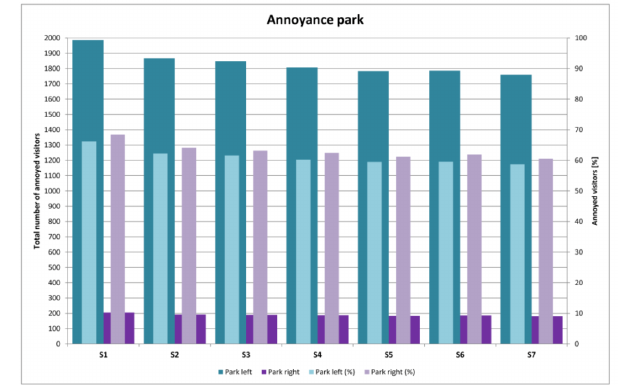
Figure 25: The total number and the percentage of annoyed people for the various scenario configurations in the Q-Zone in Athens. noyed visitors in the left and right side of the park are given in Figure 25 and Table